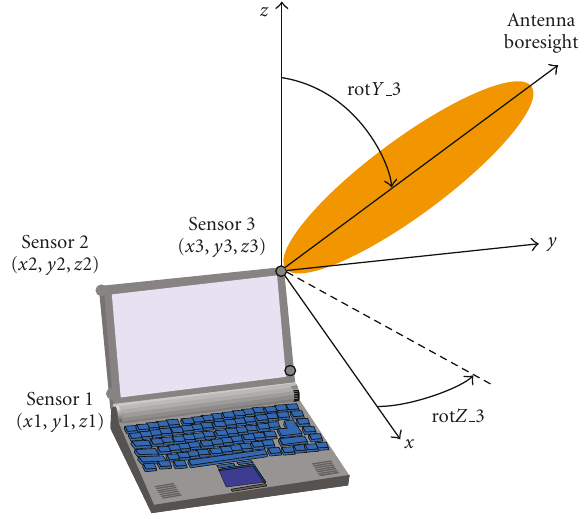
Figure 10: Sensors rotation and translation